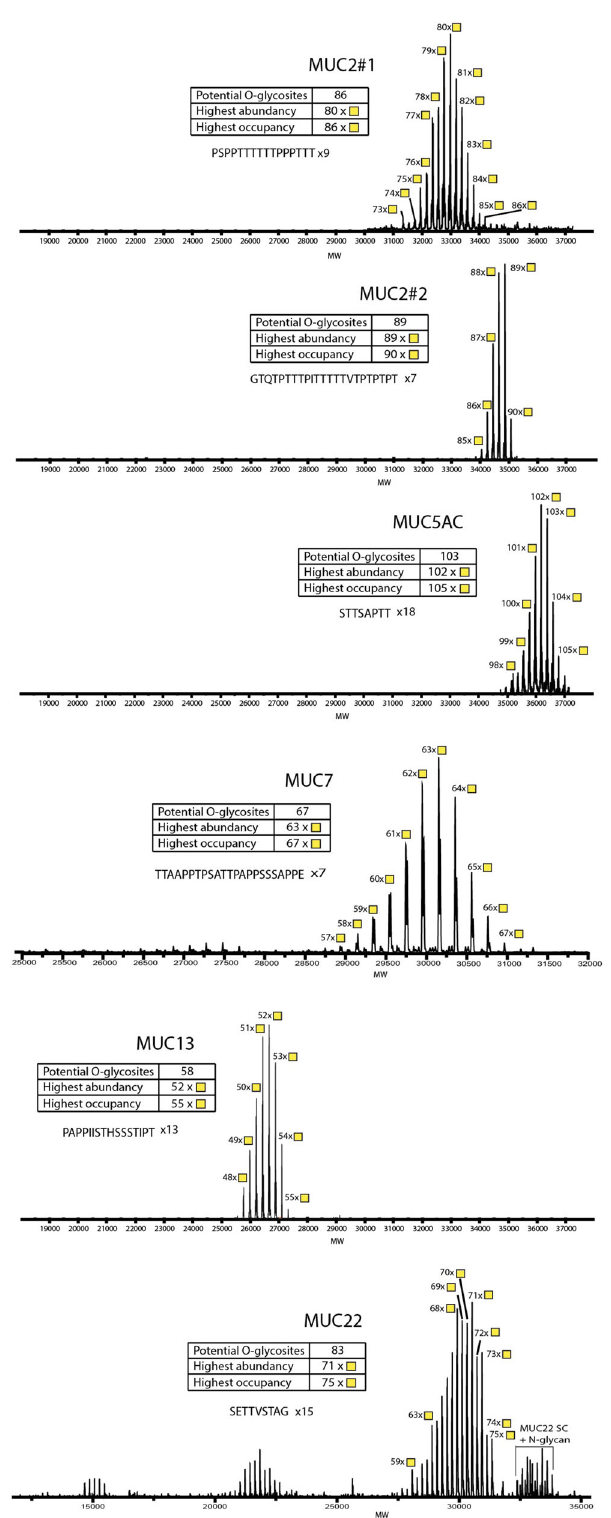
Fig. 3 Intact mass spectrometry analysis of isolated O-glycodomains of mucin TR reporters. Deconvoluted intact mass spectra of secreted, puri fi ed mucin TR reporters expressed in HEK293 KO C1GALT1 . The mucin TR reporters designed from secreted mucins (MUC2TR#1, MUC2TR#2, MUC5AC, and MUC7) and membrane-bound classi fi ed mucins (MUC13 and MUC22) were analyzed, the most abundant masses are annotated with the predicted number of attached HexNAc residues. For all intact mass spectra experimentally determined and theoretically calculated masses were composed in Supplementary Table